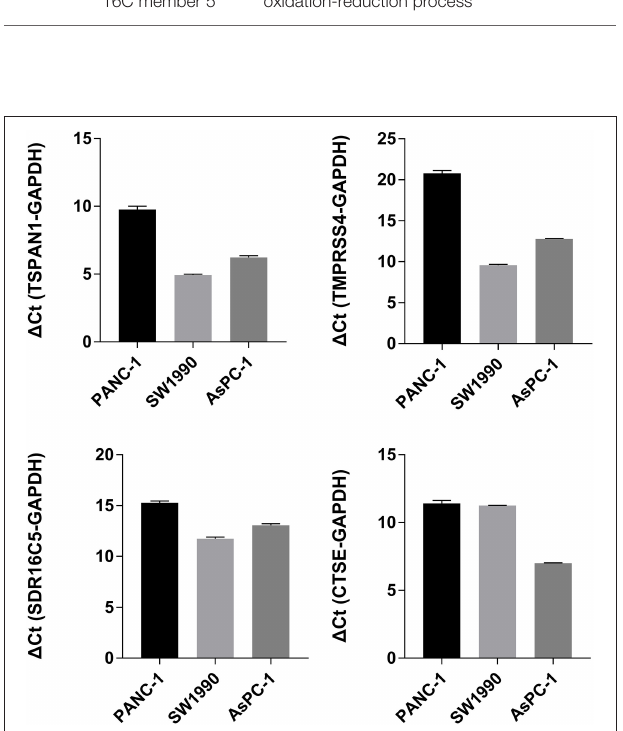
FIGURE 7 | TSPAN1 , TMPRSS4 , SDR16C5 and CTSE mRNA expression in three pancreatic cancer